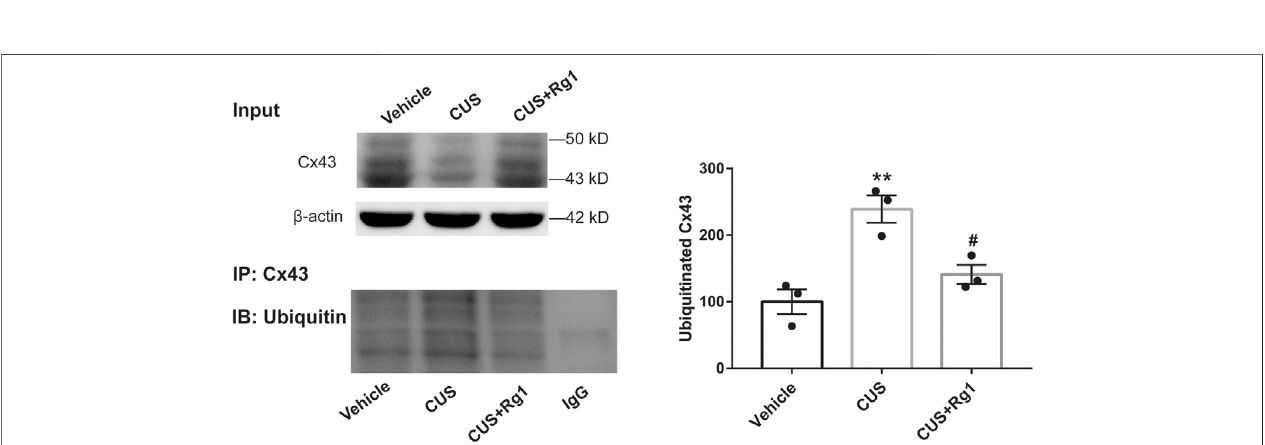
FIGURE4| Rg1decreasesubiquitinationofCx43inratsexposedtoCUS.ThetissuelysatesimmunopreciptatedusingnormalrabbitIgGorrabbitantibodyagainst total Cx43 (IP: Cx43). The immune complexes immunoblotted using an antibody against ubiquitin (IB: Ubiquitin). The blots from three independent experiments were subjected to densitometric analyses for ubiquitinated Cx43 and the results were expressed as the density of the bands in the test sample relative to those in the vehicle sample. n (cid:1) 3 per group. ** p < 0.01, compared with the vehicle group; # p < 0.05, compared with the CUS group. Cx43, connexin 43.